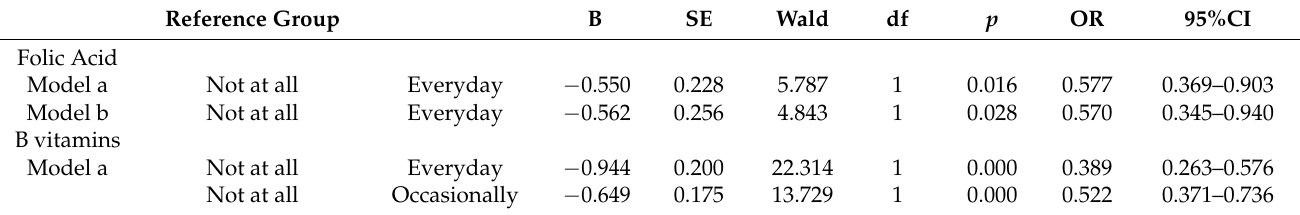
Table 3. Multivariate analysis of folic acid, B vitamins, vitamin D, CoQ10 (as categorical variable) (comparison between the normal cognitive group and the cognitive impairment